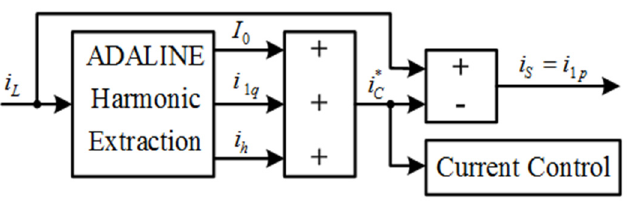
Figure 4. The fundamental active current computational process.